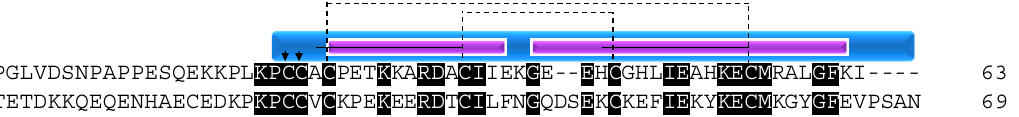
Figure 2. COX17. Alignment of human and yeast COX17 protein sequences. Human sequence annotation is as follows: Black boxes indicate conserved residues. Blue box indicates the CHCH domain. Purple boxes indicate a helix. Solid black lines indicate the twin CX 9 C motif. Dashed lines indicate the cysteine pairs that form structural disulfide bonds. Arrows indicate copper binding cysteines.